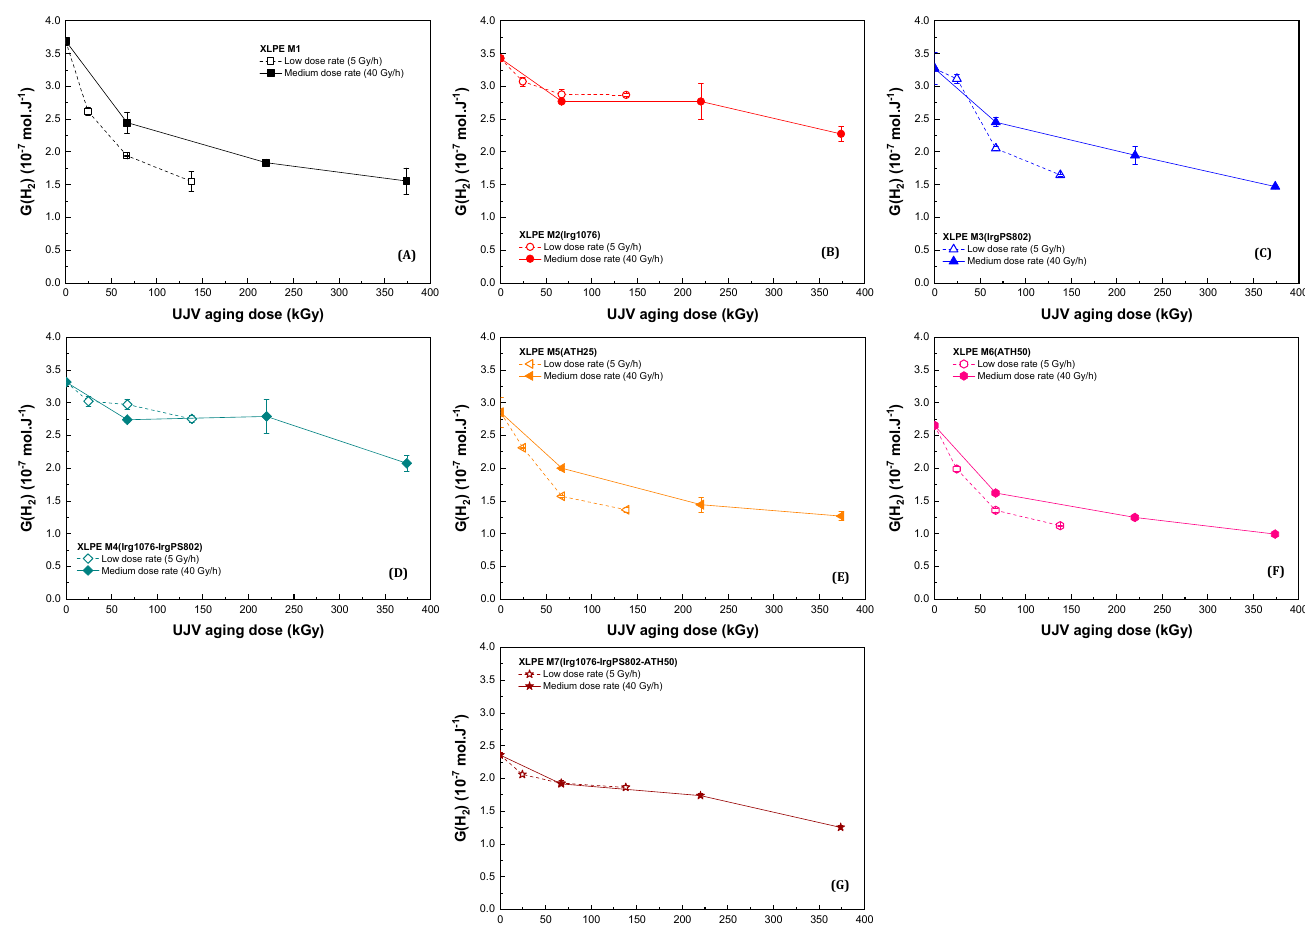
Figure 3. Hydrogen emission radiation chemical yield evolutions as a function of dose at two different dose rates (open symbols for 5 Gy · h − 1 and solid symbols for 40 Gy · h − 1 ), for ( A ) XLPE M1, ( B ) XLPE M2(Irg1076), ( C ) XLPE M3(IrgPS802), ( D ) XLPE M4(Irg1076-IrgPS802), ( E ) XLPE M5(ATH25), ( F ) XLPE M6(ATH50), and ( G ) XLPE M7(Irg1076-IrgPS802- ATH50).